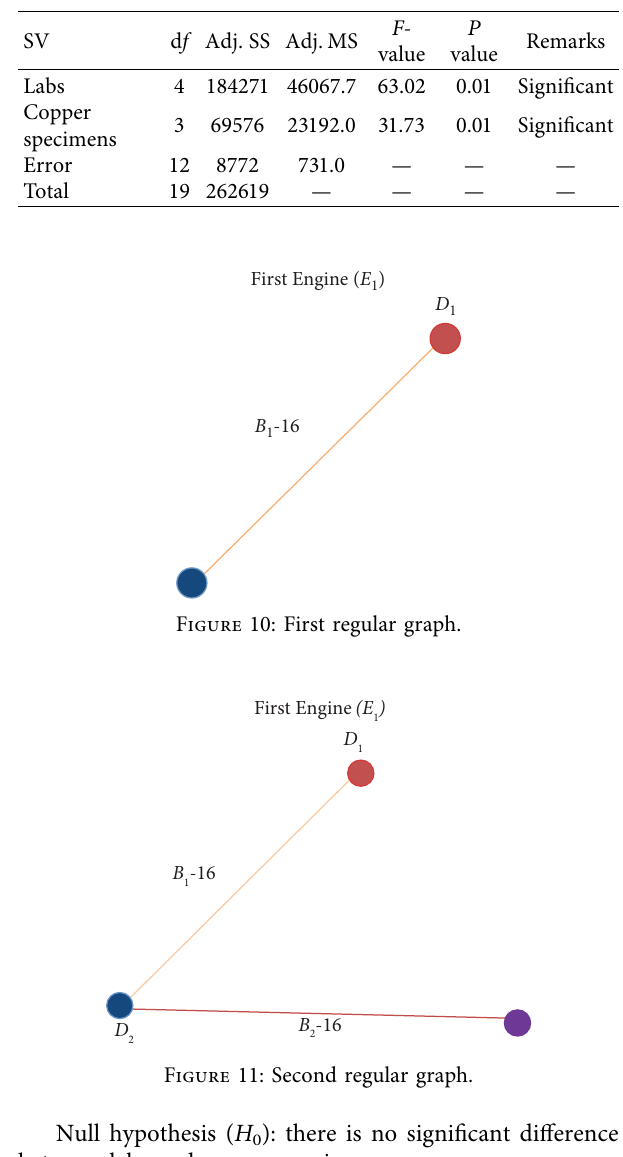
Table 4: ANOVA for response.